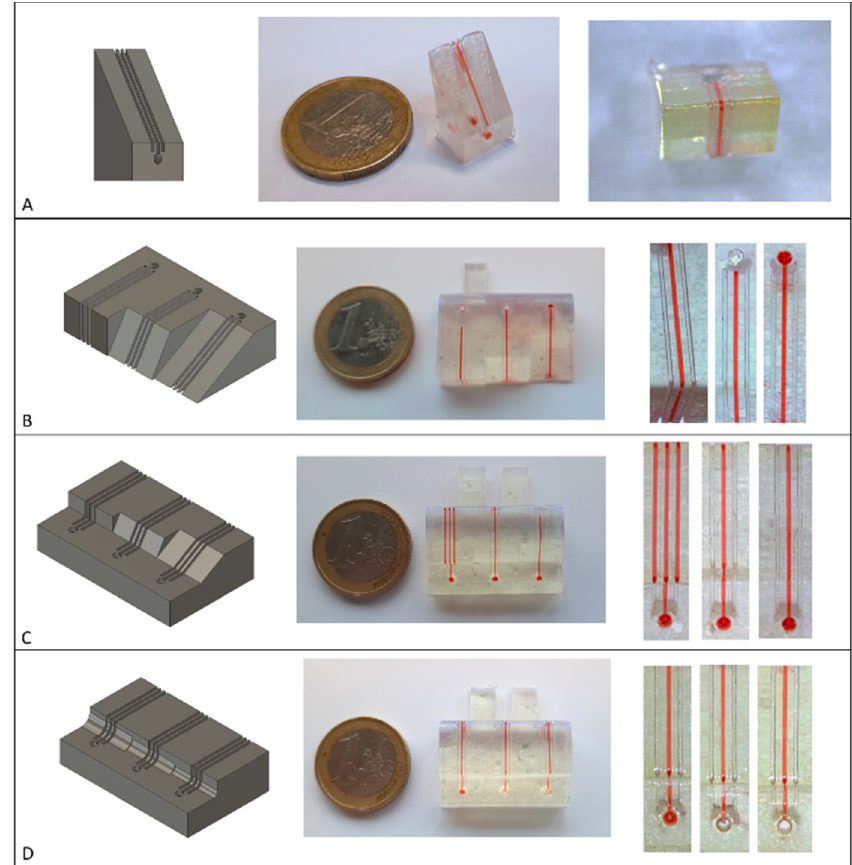
Figure 4. Different structures for testing channel integrity while traversing different angles. Left: Rendering of the structure. Middle: Completed print sealed with the topographical vacuum forming method. Right: Magnified channels. ( A ) 330° angle. ( B ) From left to right: 270° 240° and 210° angles. ( C ) From left to right: 90°, 120° and 150° angles. ( D ) From left to right: 90° angles with 2 mm, 1.5 mm and 1 mm radius fillets.